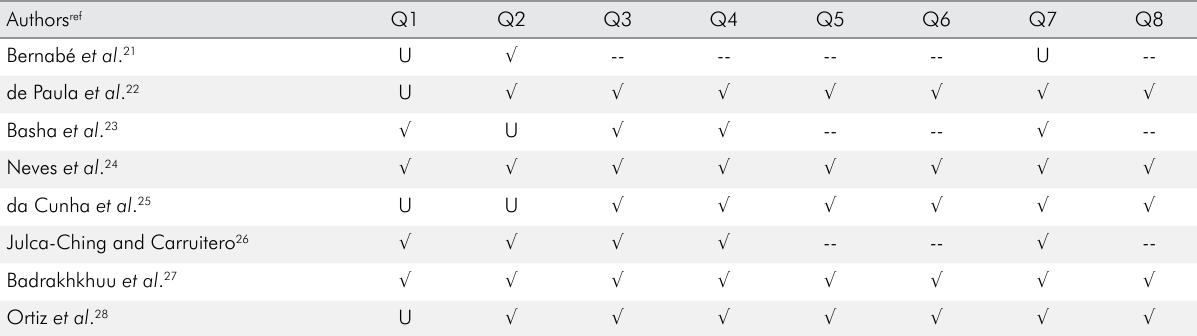
Table 4. Risk of bias assessed with the Joanna Briggs Institute Critical Appraisal Tools for use in the JBI Critical Appraisal Checklist for Analytic Cross-Sectional